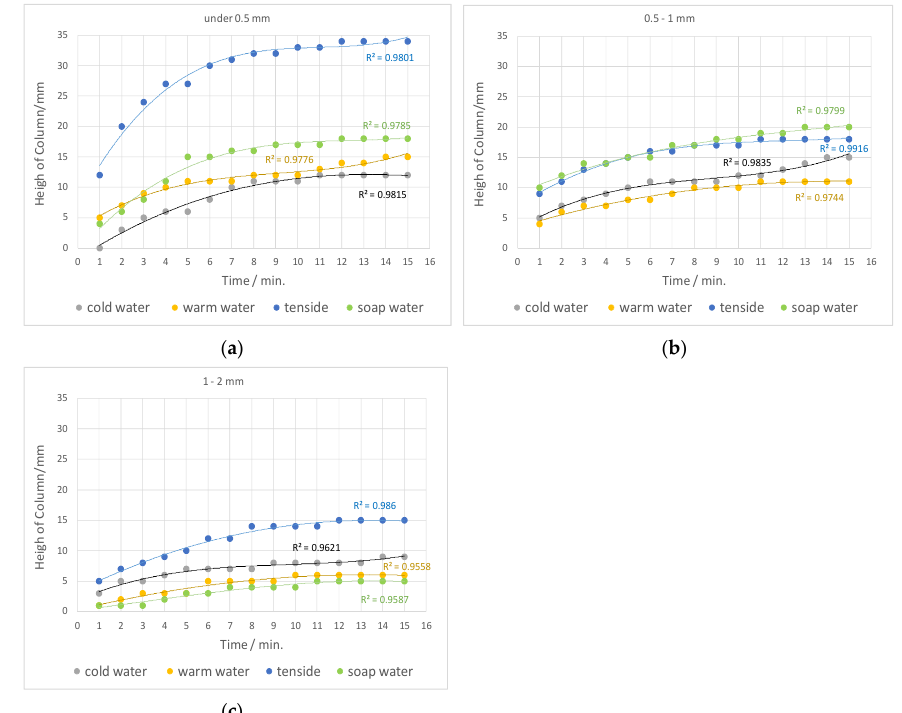
Figure 6. Wetting of biomass consisting of Miscanthus sinensis at granulometric compositions: ( a ) Figure6. WettingofbiomassconsistingofMiscanthussinensisatgranulometriccompositions: ( a )Under Under 0.5 mm; ( b ) 0.5–1 mm; ( c ) 1–2 mm. 0.5 mm; ( b ) 0.5–1 mm; ( c ) 1–2